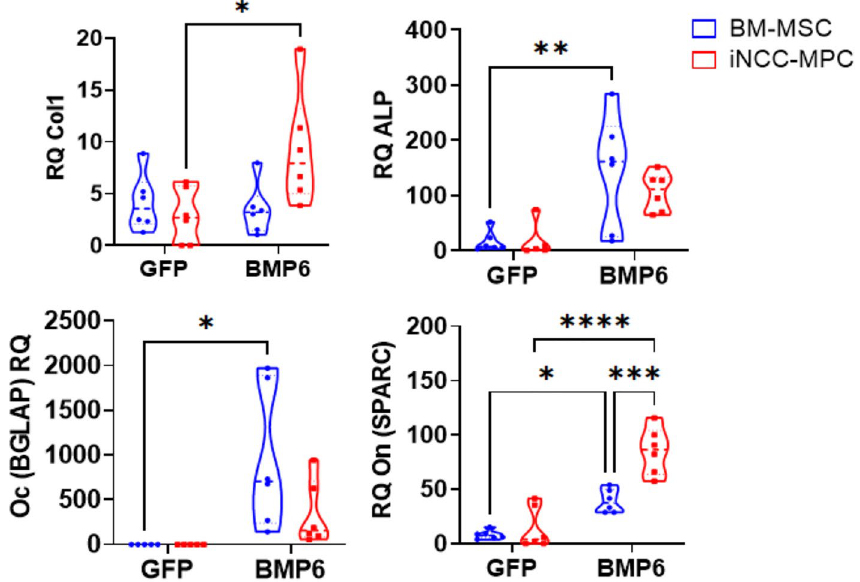
Figure 4. Osteogenesis marker expression increases in BMP6 transfected cells in Ink-Bone. ( A ) Cells were cultured in 2D or in bio-ink 3D constructs in osteogenic media. Osteogenic gene expression was tested on Day 10. ( B ) Gene expression of cells transfected with BMP6 and cultured in Ink-Bone constructs for 10 days. * p < 0.05, ** p < 0.01, *** p < 0.001, **** p < 0.0001, n ≥